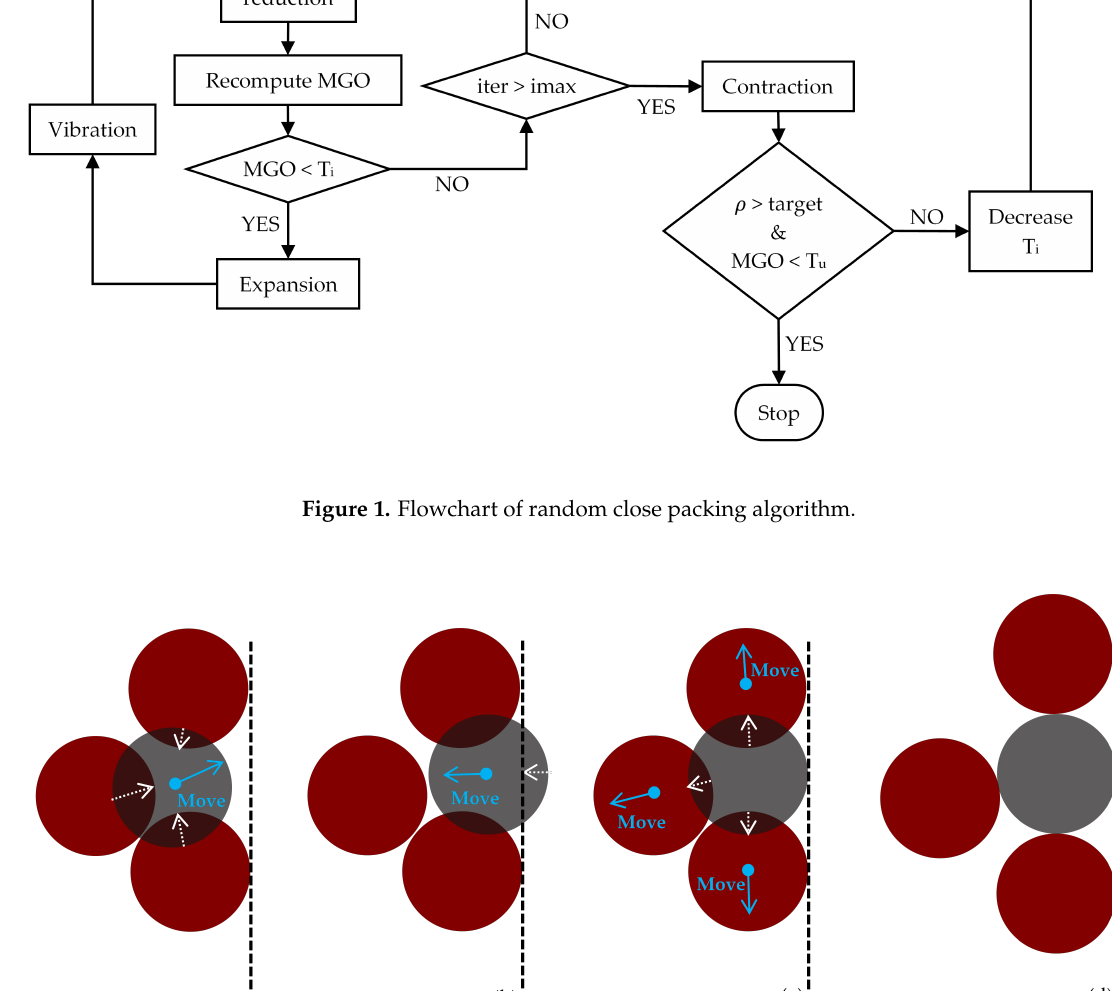
Figure 2. Schematic representation of sphere-wall interaction. ( a ) selected sphere movement based on overlap-minimizing vector; ( b ) selected sphere being moved in direction of central axis; ( c ) moving overlapping spheres to tangent position with selected sphere; ( d ) final